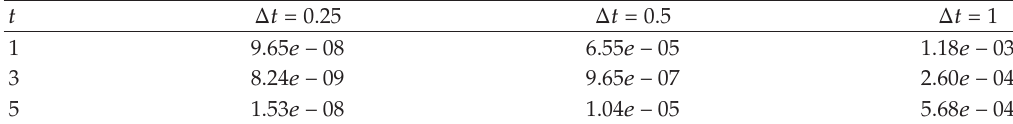
Table 6: Relative errors of Problem 3 with N (cid:6) M (cid:6) 11 , α (cid:6) β (cid:6) 1.